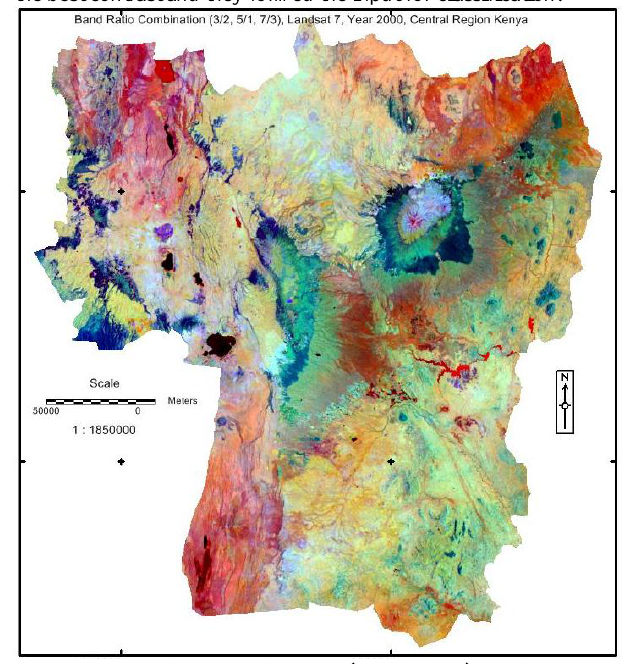
Figure 4: Band ratio combination (3/2, 5/1, 7/3), Landsat